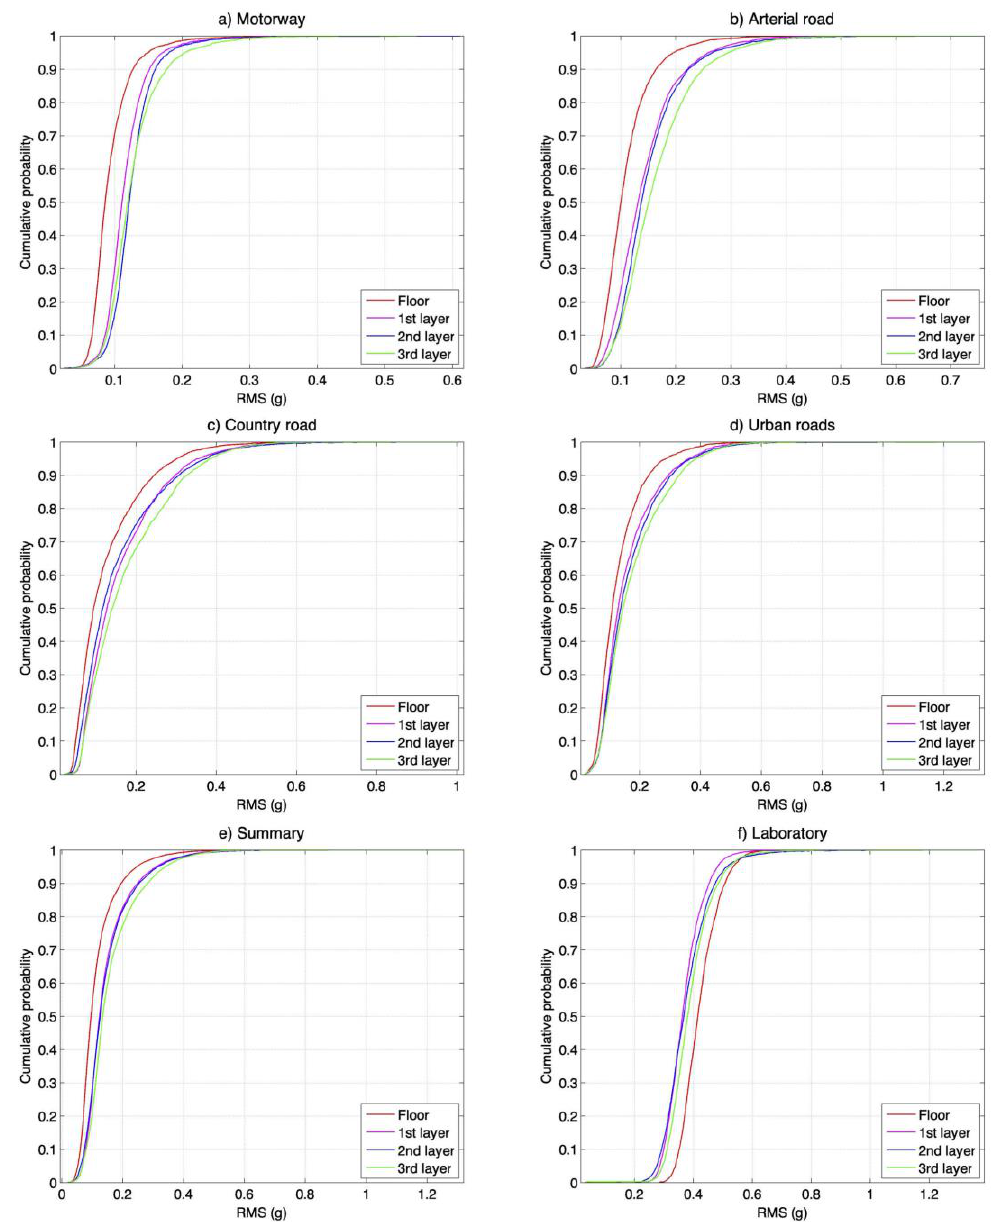
Figure 8. Empirical CDFs of RMS (g) values, ( a ) Motorway, ( b ) Arterial road, ( c ) Country road, ( d ) Urban roads, ( e ) Summary, ( f ) Laboratory.